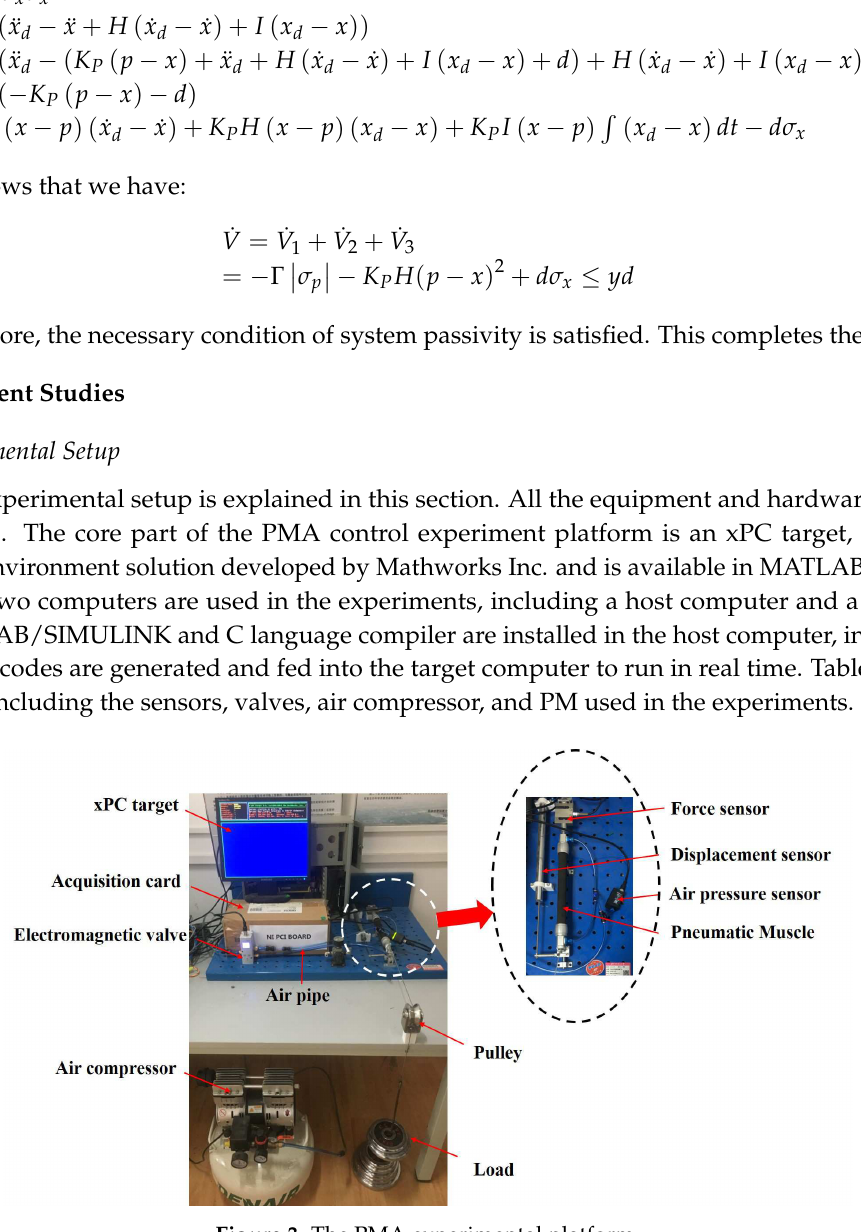
Figure 3. The PMA experimental